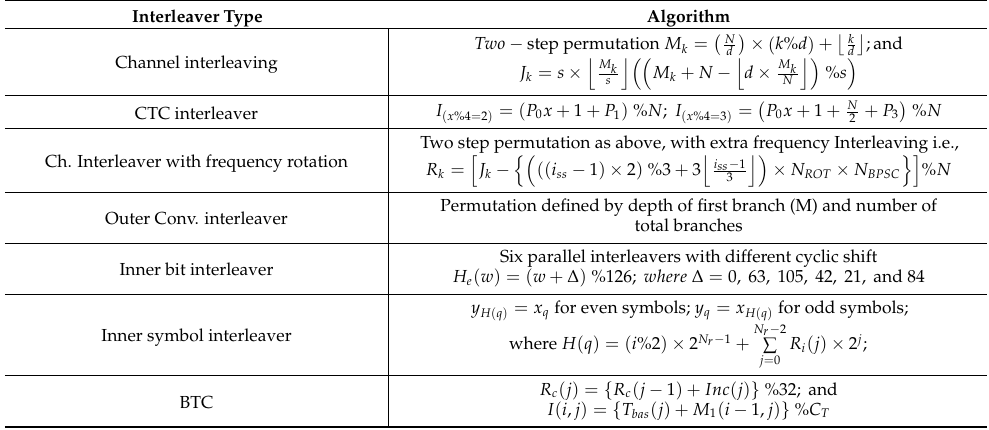
Table 1. Cont. Interleaver Type Algorithm Channel interleaving